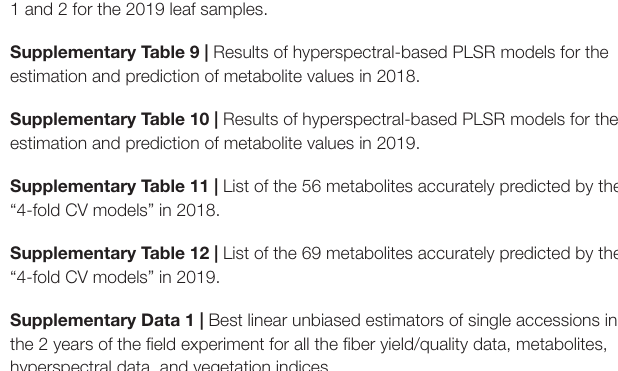
Supplementary Table 8 | Loading values of metabolites on principal component 1 and 2 for the 2019 leaf samples. Supplementary Table 9 | Results of hyperspectral-based PLSR models for the estimation and prediction of metabolite values in 2018.